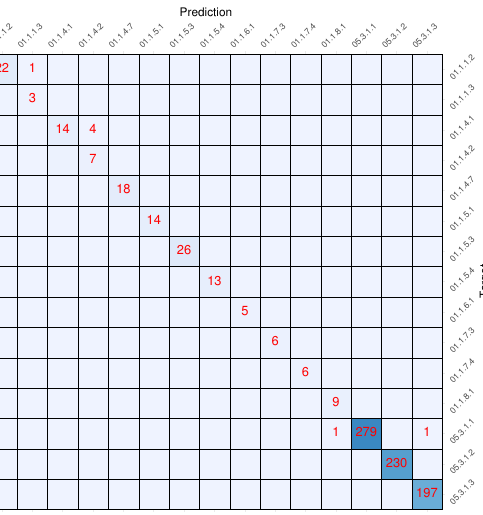
Figure 10. The confusion matrix for random forest using the FastText skip-gram